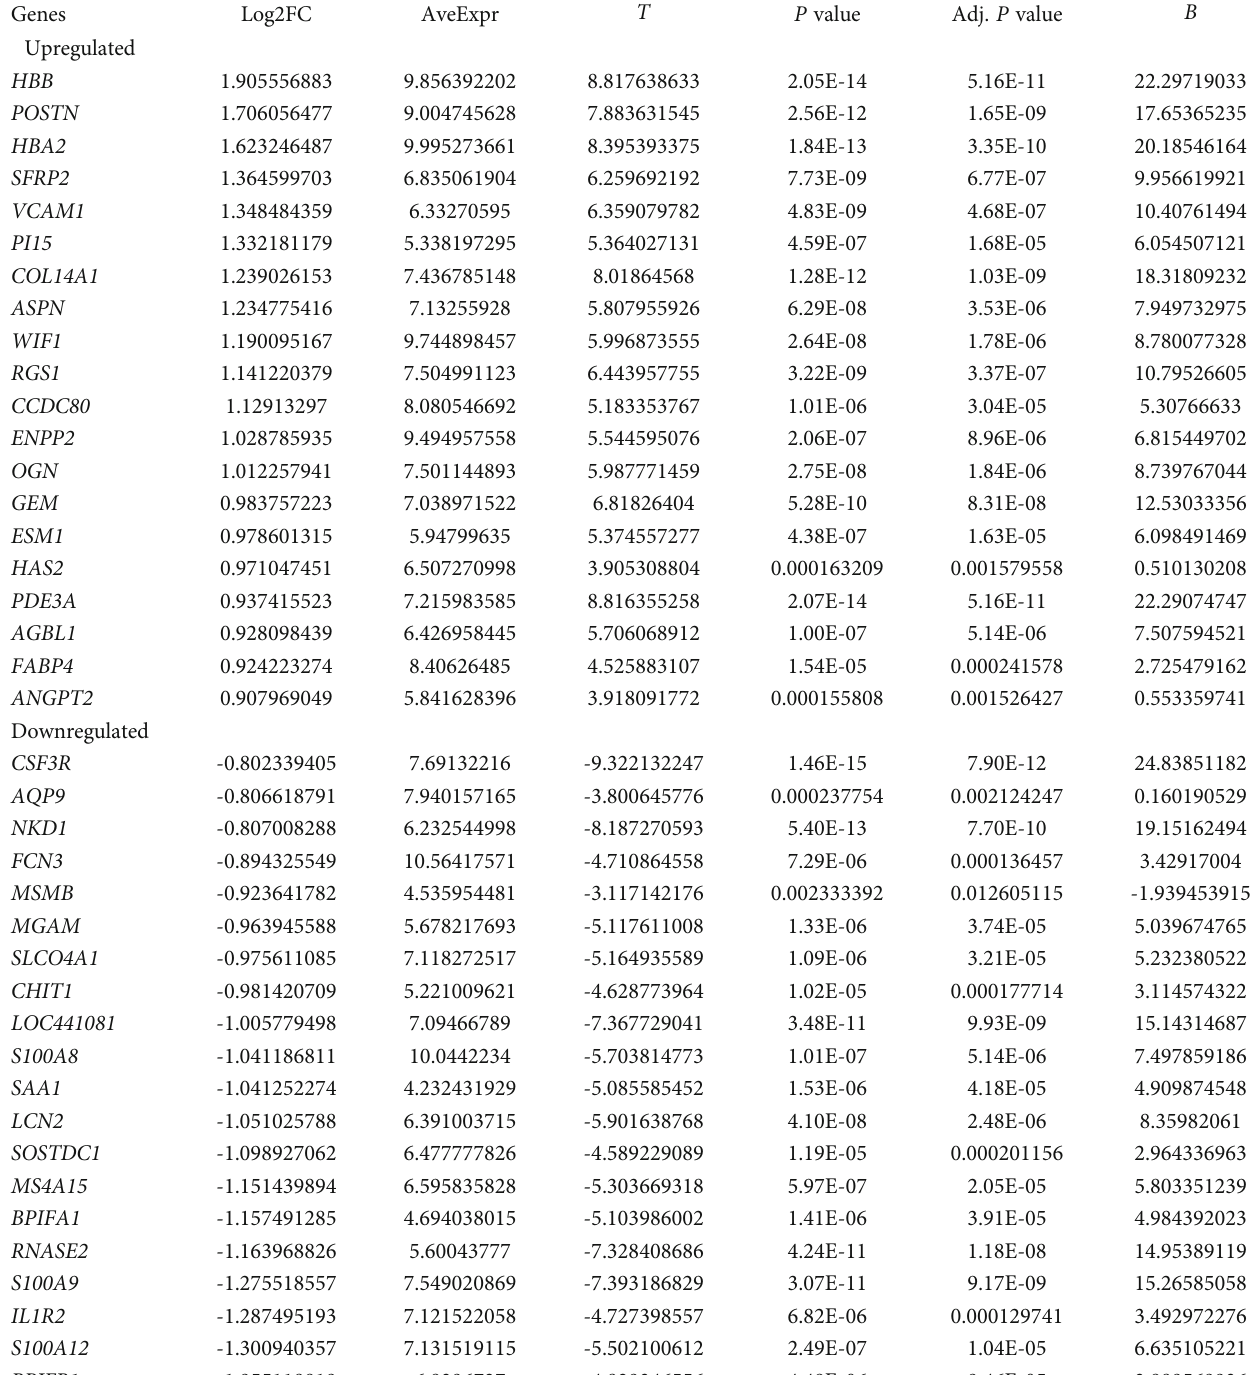
Table 2: The top 20 up- and downregulated DEGs in PAH and normal